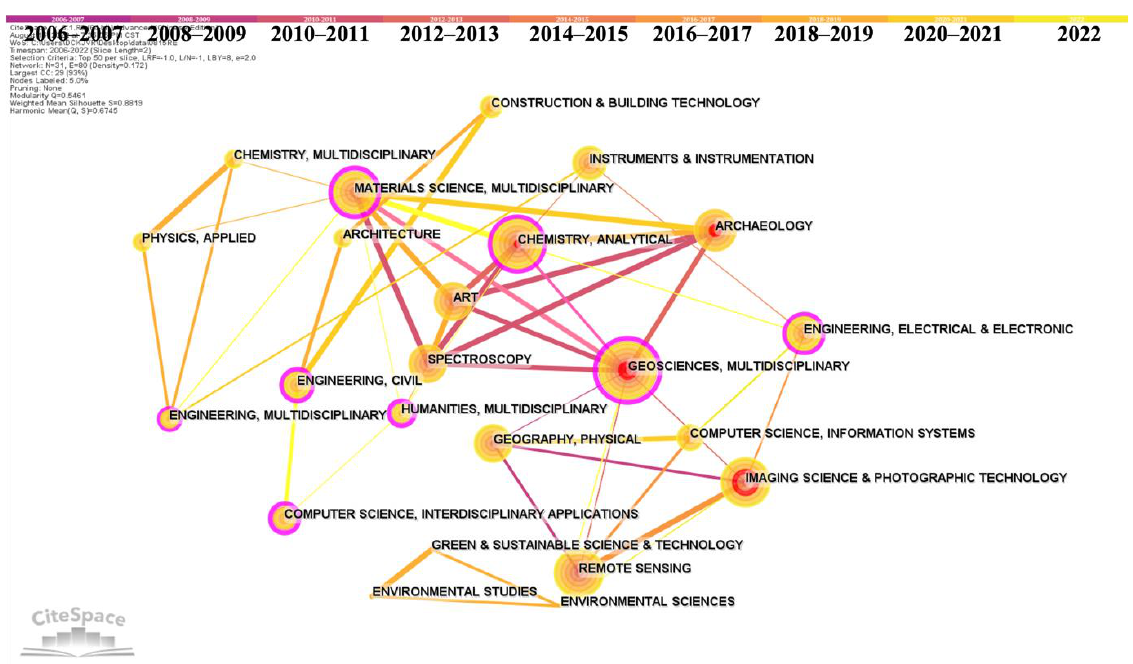
Figure 9. The visualization of the category co-occurrence network for the years 2006 – 2022.